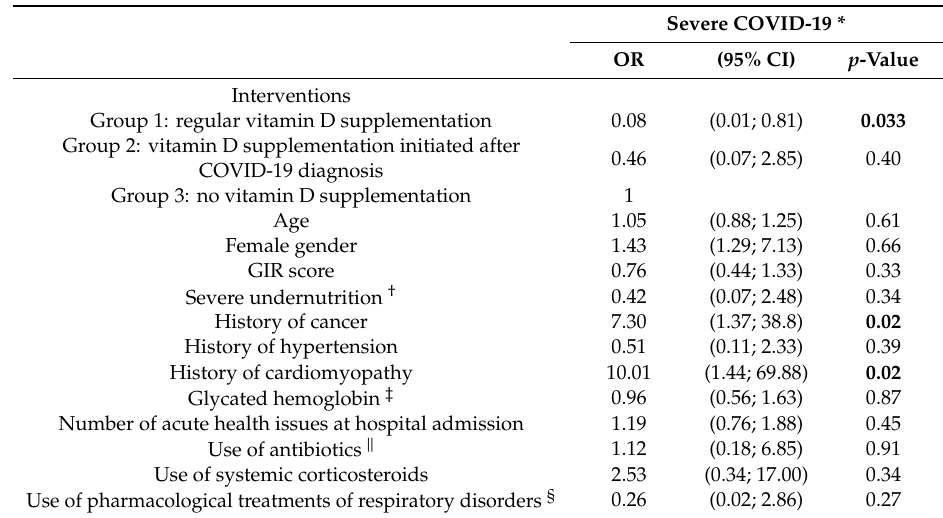
Table 2. Multiple logistic regressions showing the association between vitamin D interventions (independent variable) and the risk of severe COVID-19 * (dependent variable), adjusted for participants’ characteristics ( n =